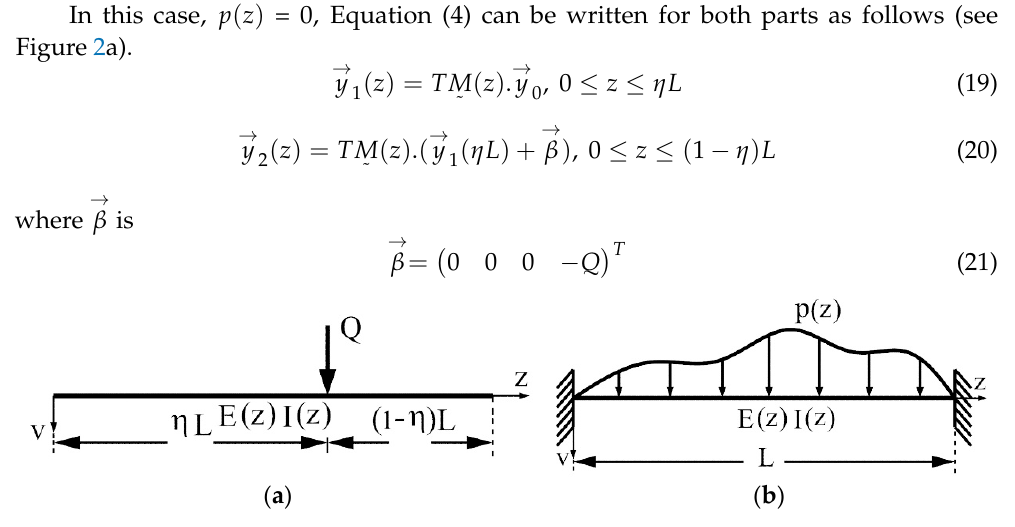
Figure 2. ( a ) Beam subjected to singular force; ( b ) both ends of a fixed beam subjected to a distributed load. The unknowns of the problem can be written as follows.